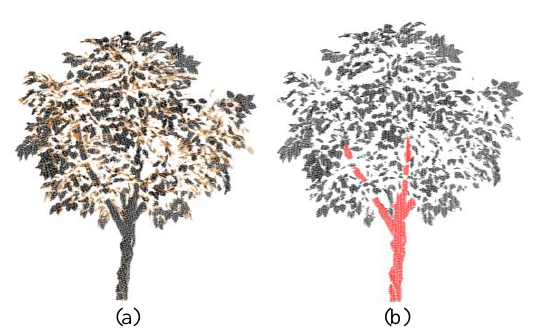
Figure 7. Results of the branch points separation (a) and stem points separation (b)